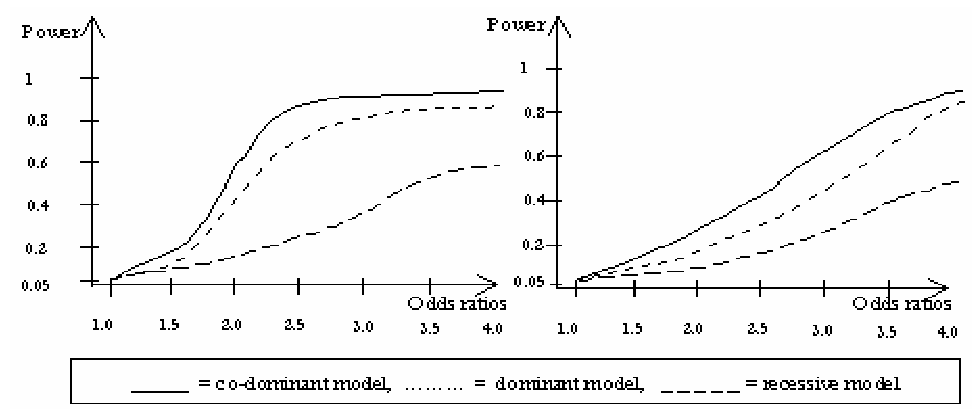
Figure 8 – Cases = controls = 500, f = 0.05. Figure 9 – Cases = controls = 50, f = 0.10.